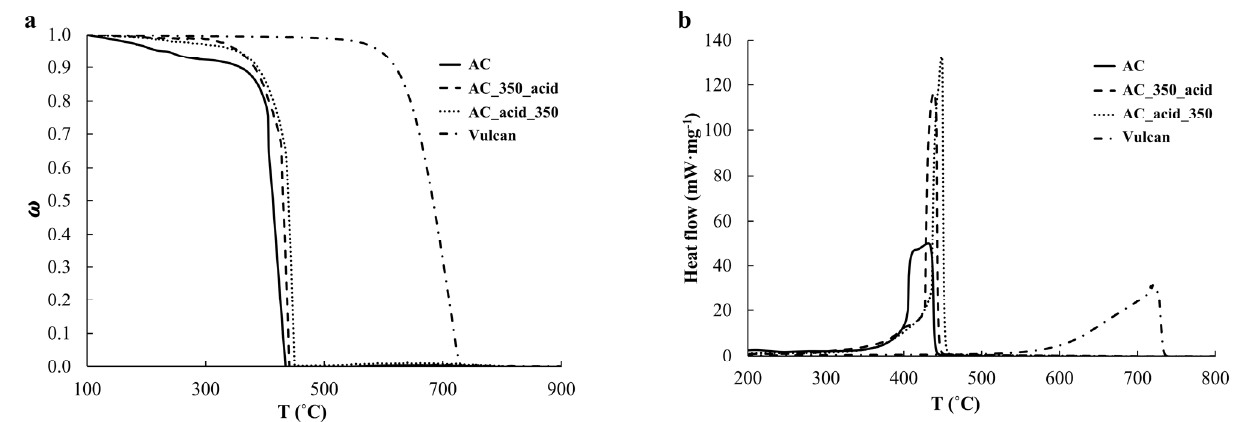
Figure 4. The TGA ( a ) and DSC ( b ) curves of the AC, AC_350_acid, and AC_acid_350